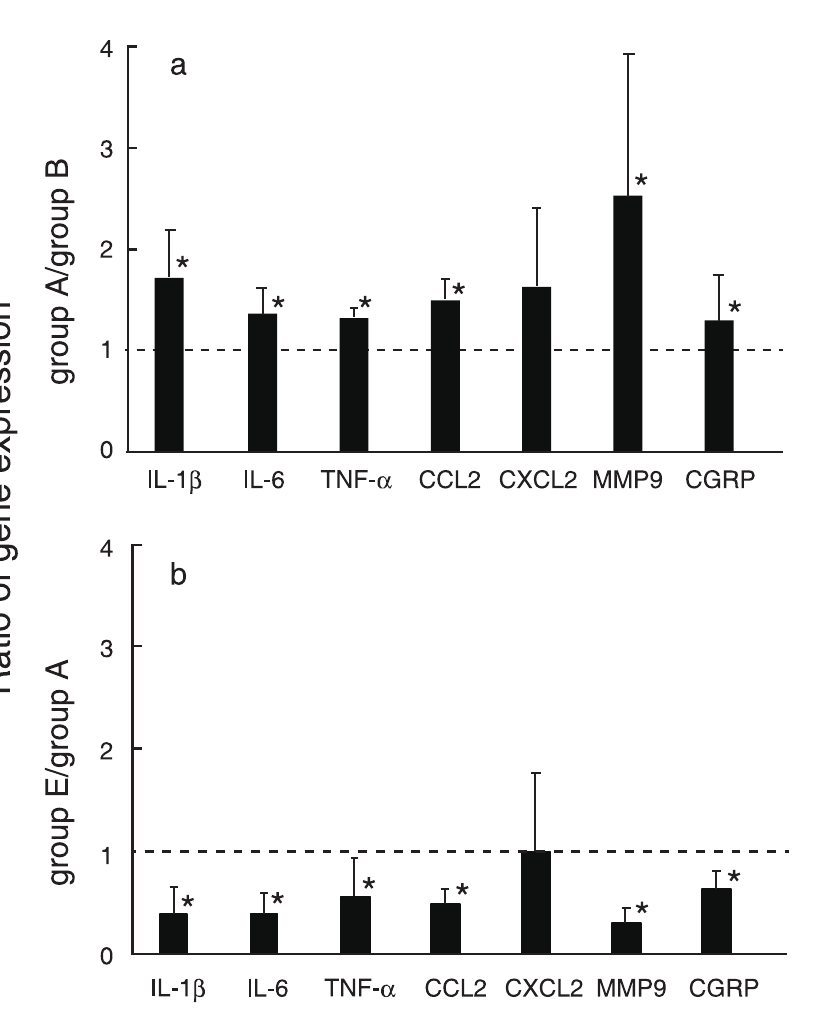
Fig 8. Effects of BMMCs and PAR2 antagonist (FSLLRY-NH 2 ) on the expression of various genes in the infrapatellar fat pads of the OA knee joints. a, Stimulation of the various gene expression by BMMCs. Height of each bar represents the ratio of the gene expression in group A to the gene expression in group B. SD was indicated above each bar. � p < 0.05. b, Suppression of the gene expression by PAR2 antagonist. Height of each bar represents the ratio of the gene expression in group E to the gene expression in group A. SD was indicated above each bar. � p < 0.05. Extraction of total RNA and qPCR were performed according to the methods described under Materials and methods. Data from four experiments were combined. Total number of mice used were 12 for each group. Expression levels of each mRNA were normalized with the expression level of β